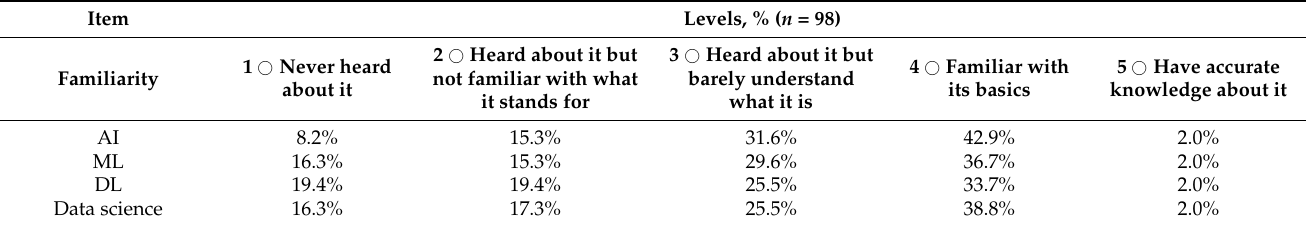
Table 2. Exposure to and interest in artificial intelligence in radiology ( n =